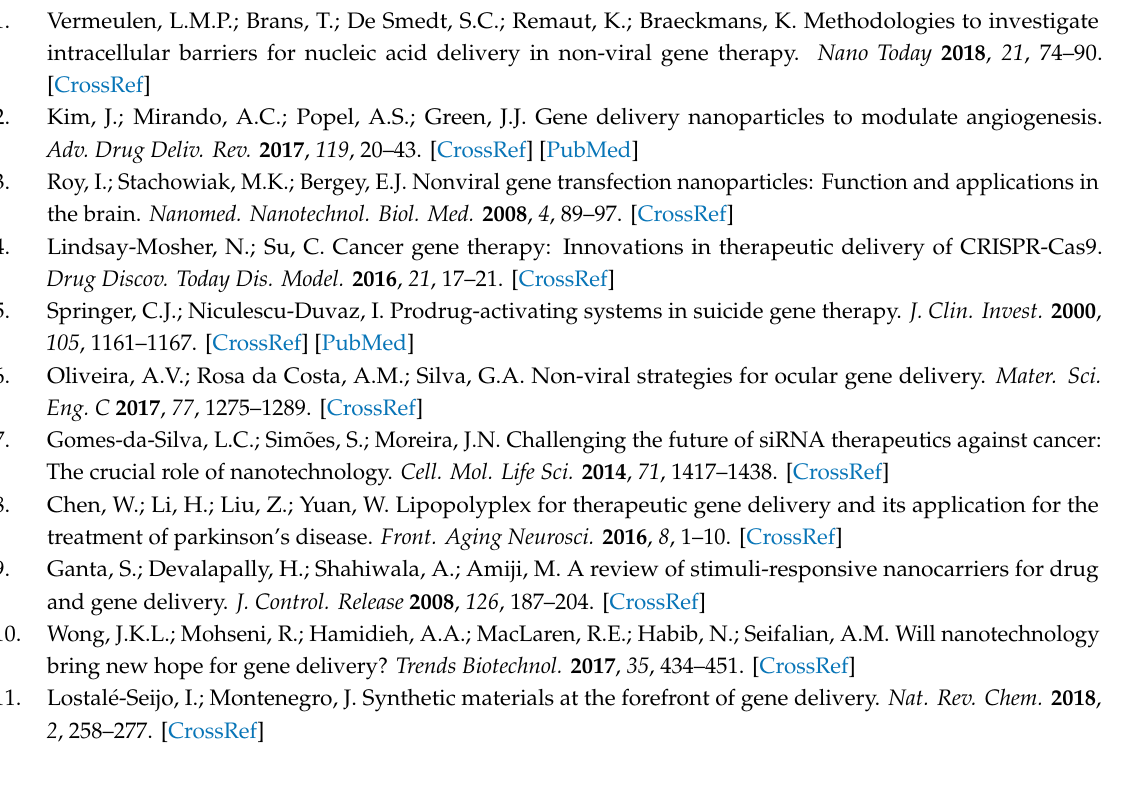
Supplementary Materials: Figure S1: Negative-stained TEM micrographs of PP PLL, Lipos and LPP PLL. Figure S2. Resazurin viability assay of A549 cells incubation with PPs and LPPs for 72 h. Figure S3. 1 H NMR and Raman spectra of the peptide CKKKKKC and the prepared bioreducible polymer